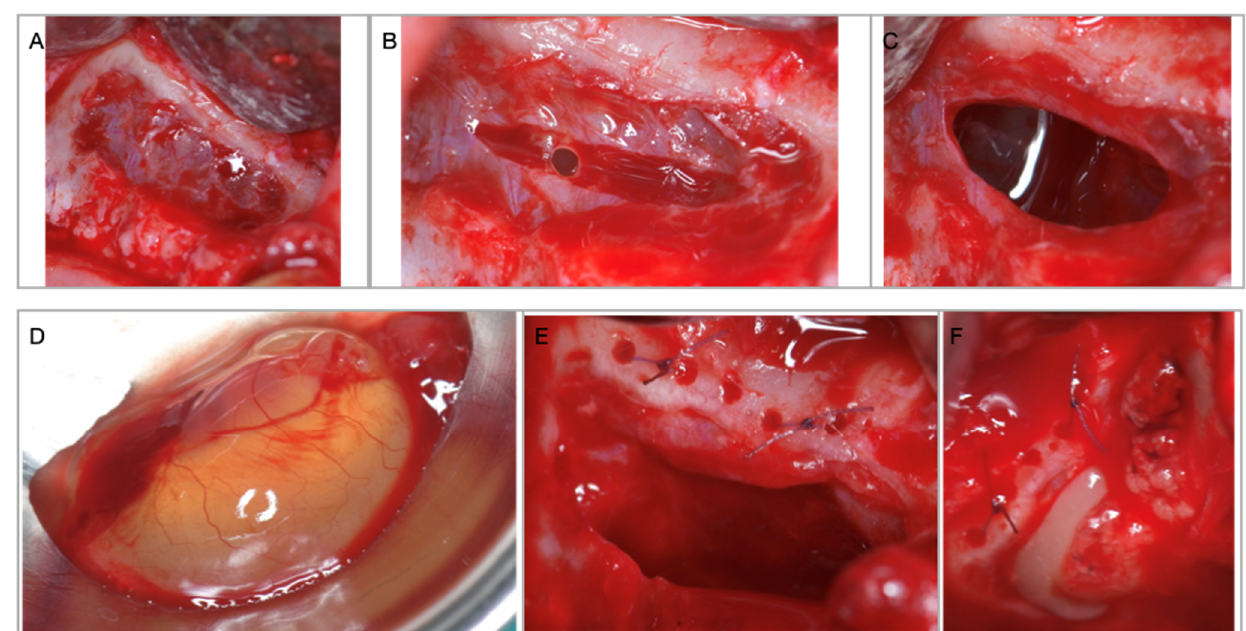
Figure 3. ( A ) Access window through the anterior wall of the maxillary sinus with intact Schneiderian membrane. ( B ) Deliberate incision in the sinus membrane for mucocele removal. ( C ) Size of the perforation necessary for cyst removal. ( D ) Maxillary sinus mucocele. ( E ) Schneiderian membrane perforation is sutured to the superior bony edge. ( F ) Sinus floor augmentation performed with PRFs after the implants are inserted.